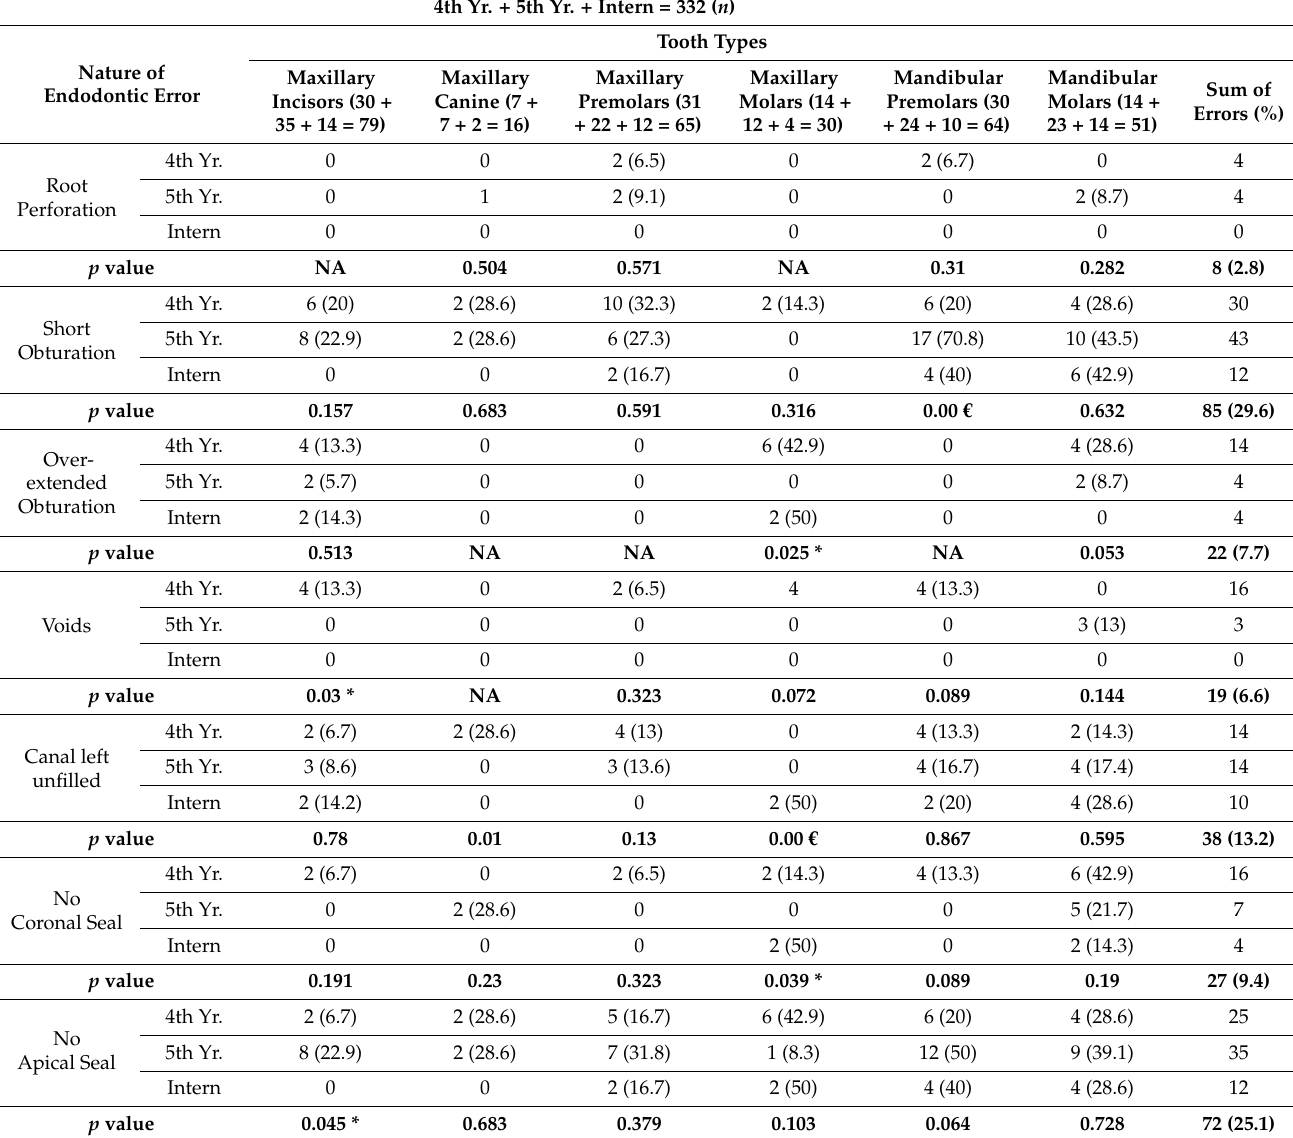
Table 6. The frequency and percentage of errors in RCF performed by different academic grades according to various tooth